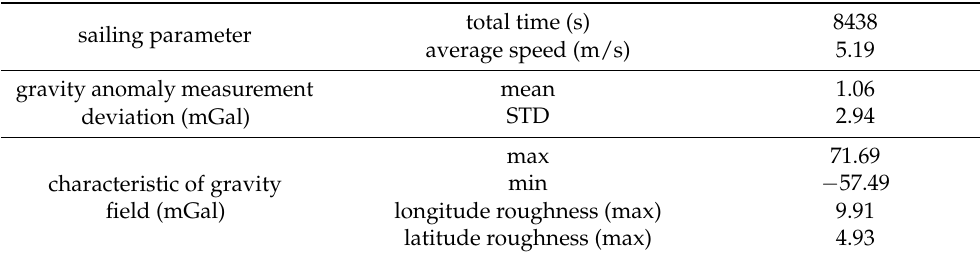
Table 1. Information of the sailing track 1.